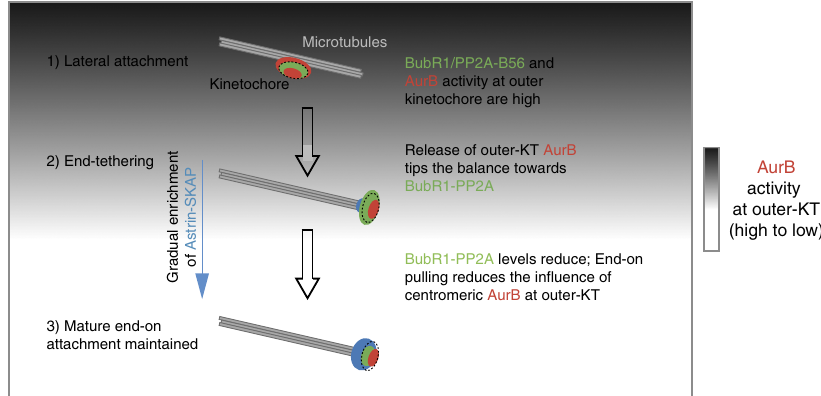
Fig. 6 Schematic description of the end-on conversion process. On laterally attached kinetochores, outer-kinetochore associated Aurora-B kinase and BubR1-PP2A phosphatase levels are high. End-on conversion requires the reduction of outer-kinetochore associated Aurora-B activity, which potentially tips the balance in favour of BubR1-associated PP2A phosphatase allowing the gradual recruitment of Astrin-SKAP complex. Concomitantly, end-tethered kinetochores experience end-on pulling and intra-kinetochore tension, which can spatially separate centromeric Aurora-B from outer-kinetochore substrates. This progressive reduction in Aurora-B activity at the outer-kinetochore will promote further enrichment of Astrin-SKAP complex — a crucial late event in end-on conversion that is essential to maintain mature end-on attachments. Red circles mark outer and inner kinetochore associated Aurora-B, green circles mark BubR1 and blue circles mark